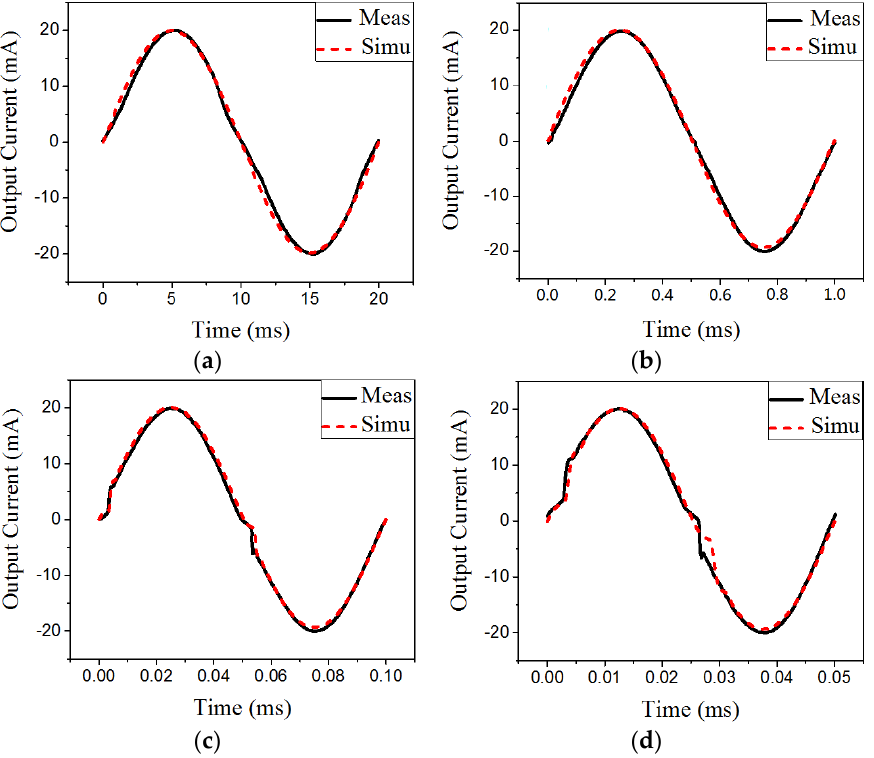
Figure 9. Comparison between simulation and measurement. ( a ) 100 A & 50 Hz; ( b ) 100 A & 1 KHz; ( c ) 100 A & 10 KHz. ( d ) 100 A & 20 KHz. ( c ) 100 A & 10 KHz. ( d ) 100 A & 20 KHz.